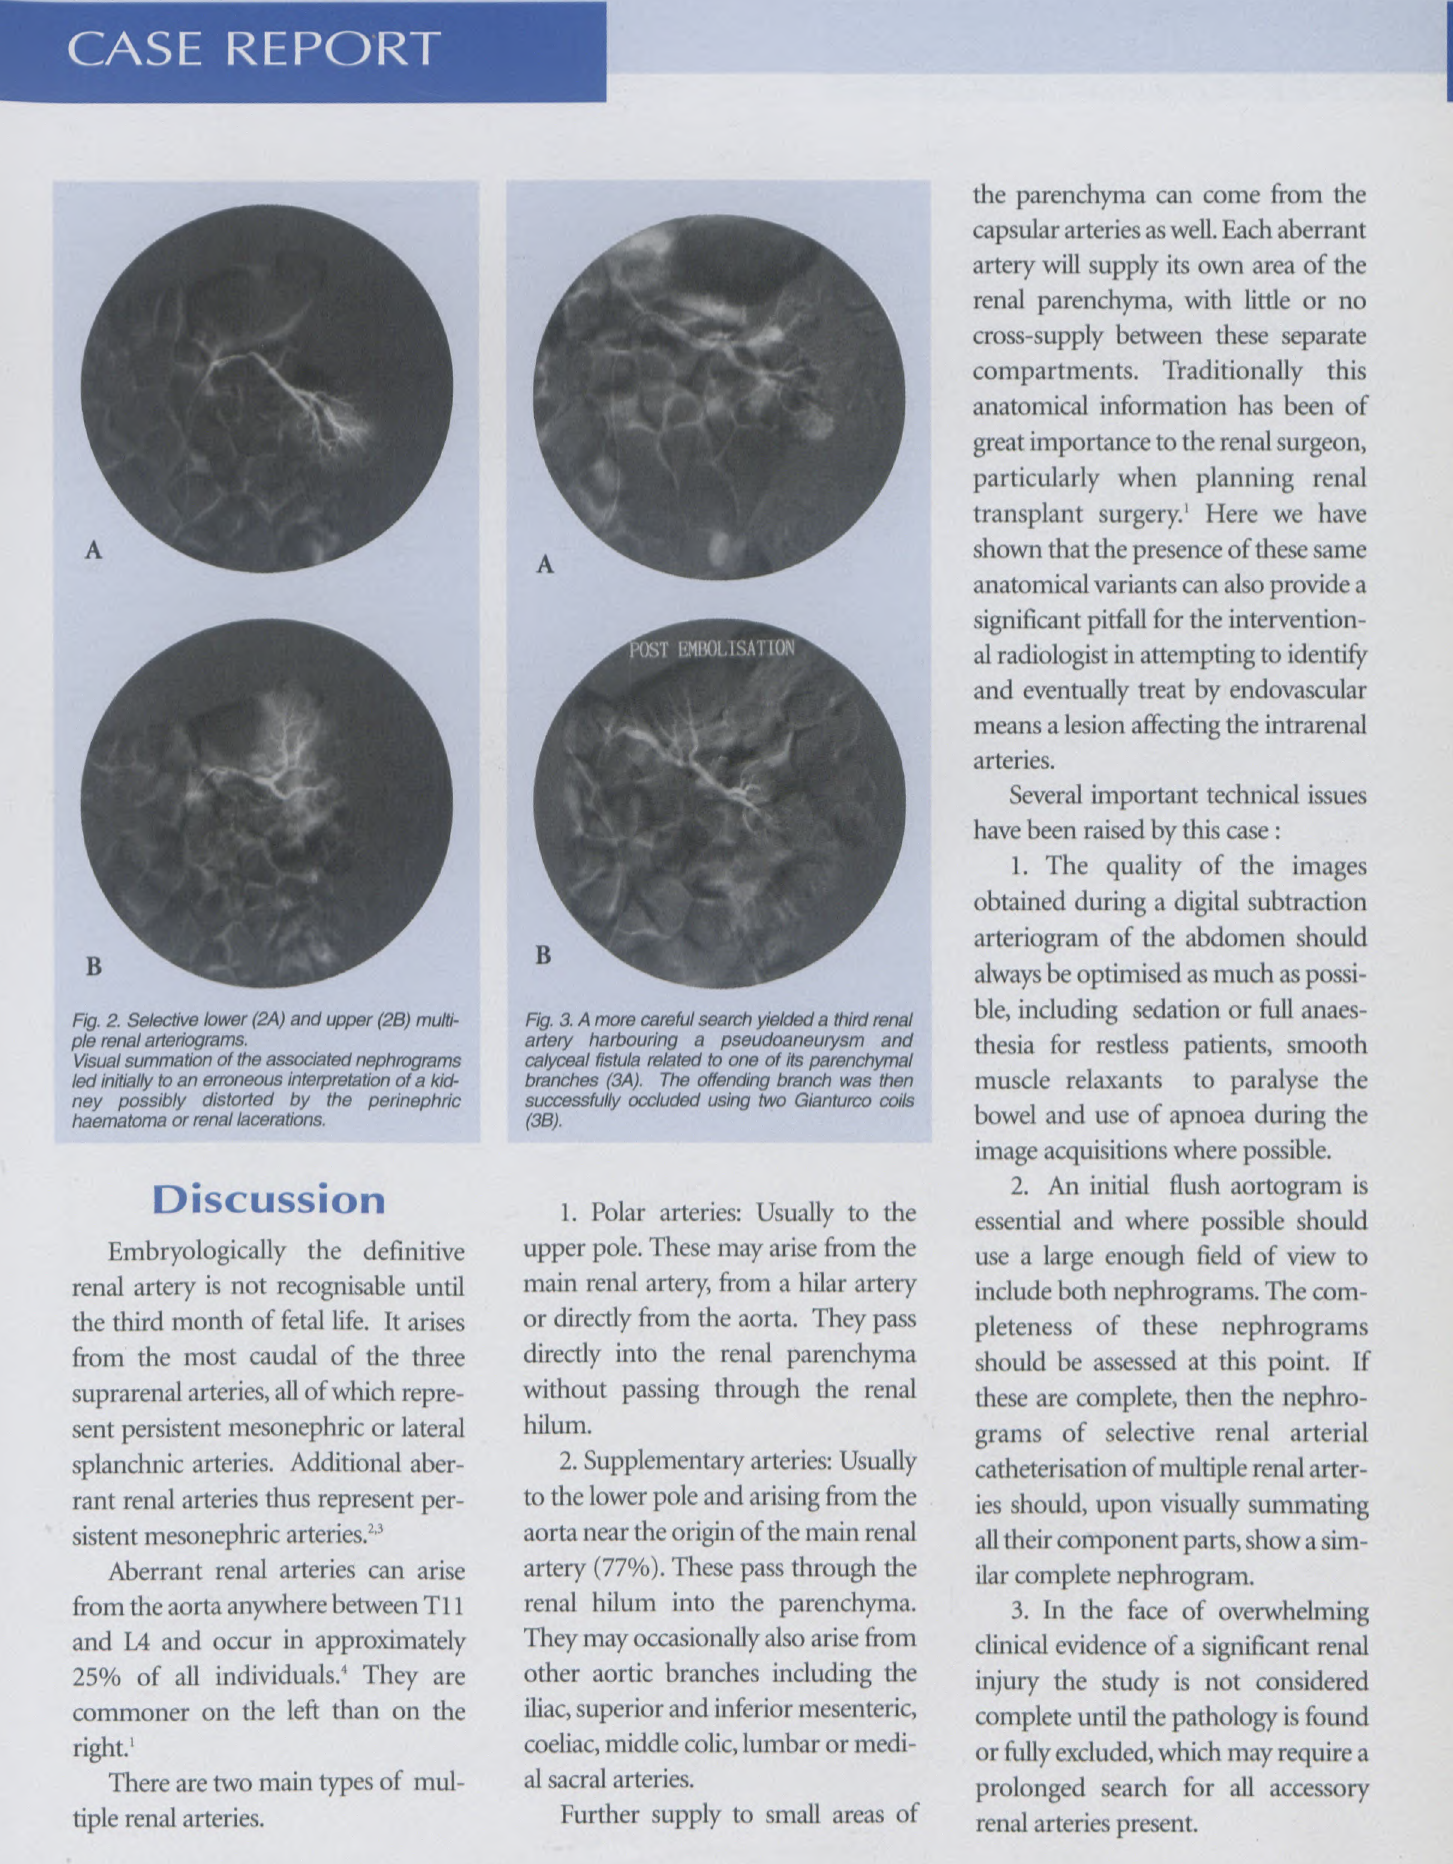
Fig. 3. A more careful search yielded a third renal artery harbouring a pseudoaneurysm and calyceal fistula related to one of Its parenchymal branches (3A). The offending branch was then successfully occluded using two Gianturco coils